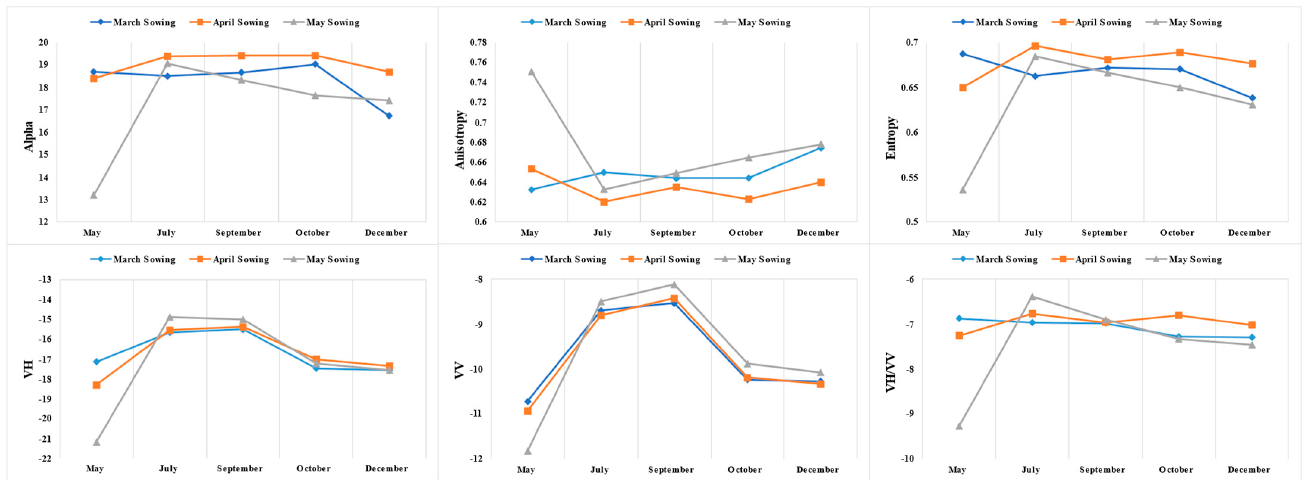
Figure 4. Temporal profile of Sentinel-1 parameters.